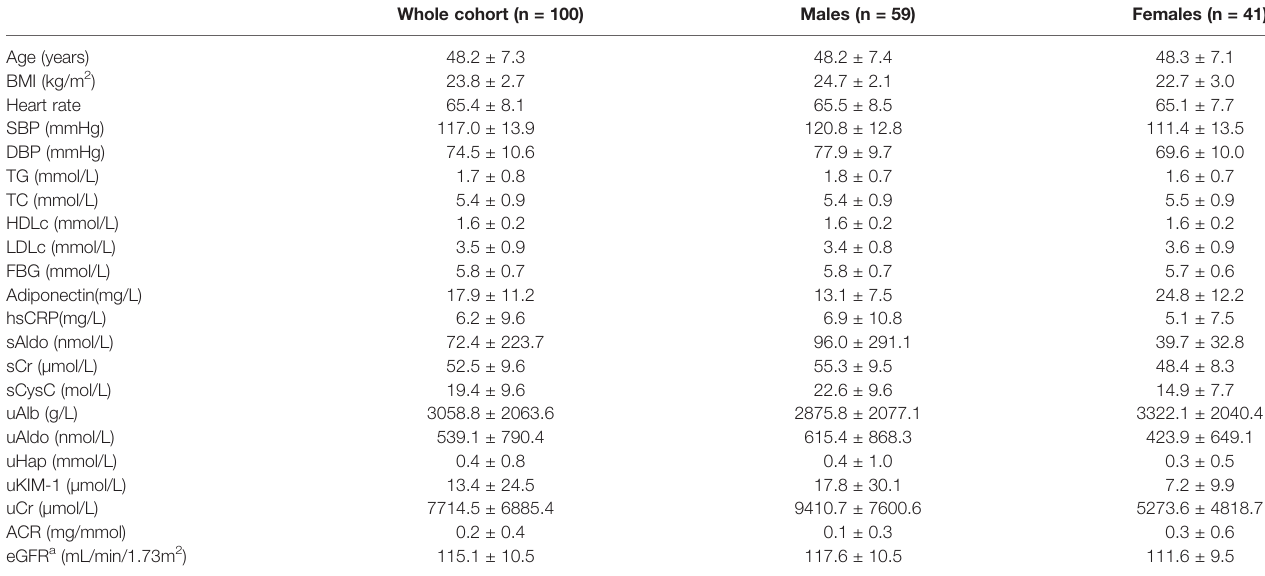
TABLE 1 | Characteristics of the study